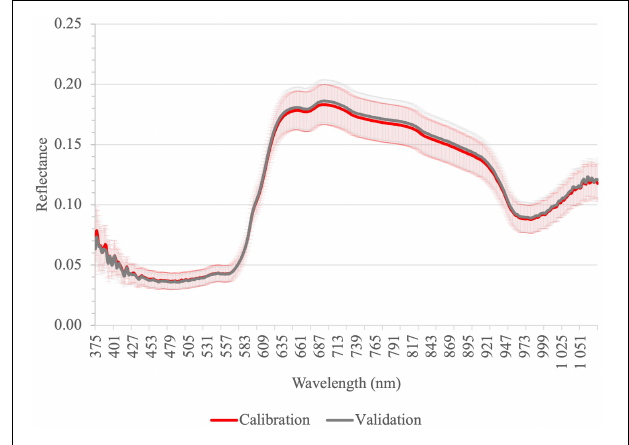
FIGURE 1 | Average reflectance spectra of intact tomato fruit samples for calibration and validation in Vis-NIR by ASD; vertical bars represent the standard deviation (calibration n = 99; validation n = 33).